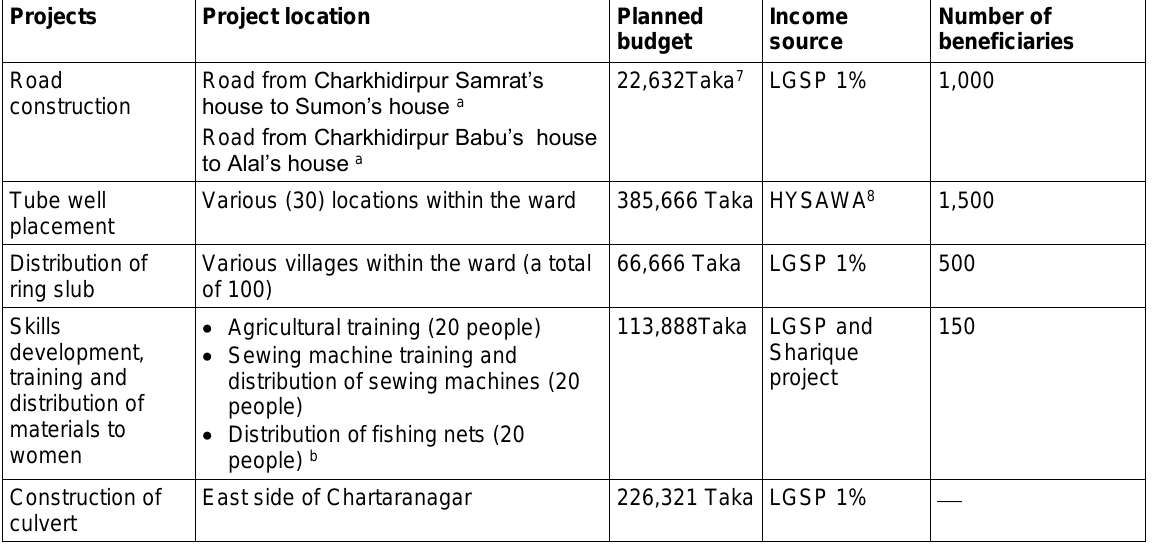
Table 4: Case-study: WS plans of Ward 7, Hariyan UP, for